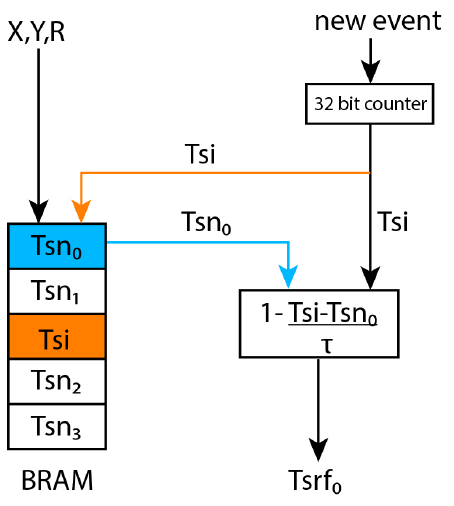
Figure 4. Time-surface generator module